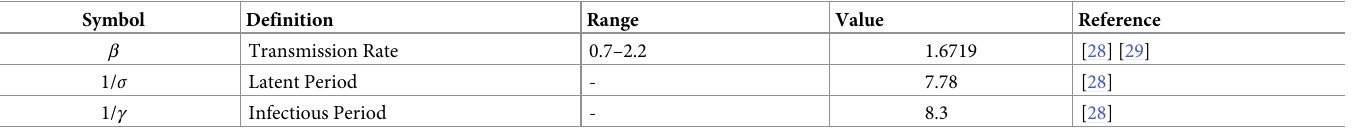
Table 5. ASFV epidemic model